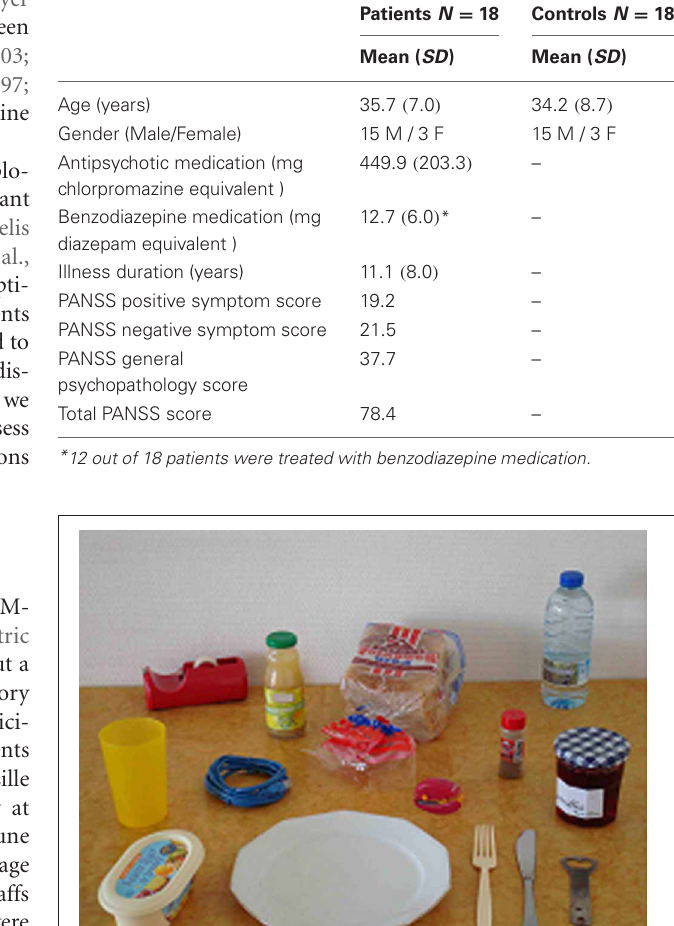
Table 1 | Means and standard deviations ( SD ) of participant demographics.